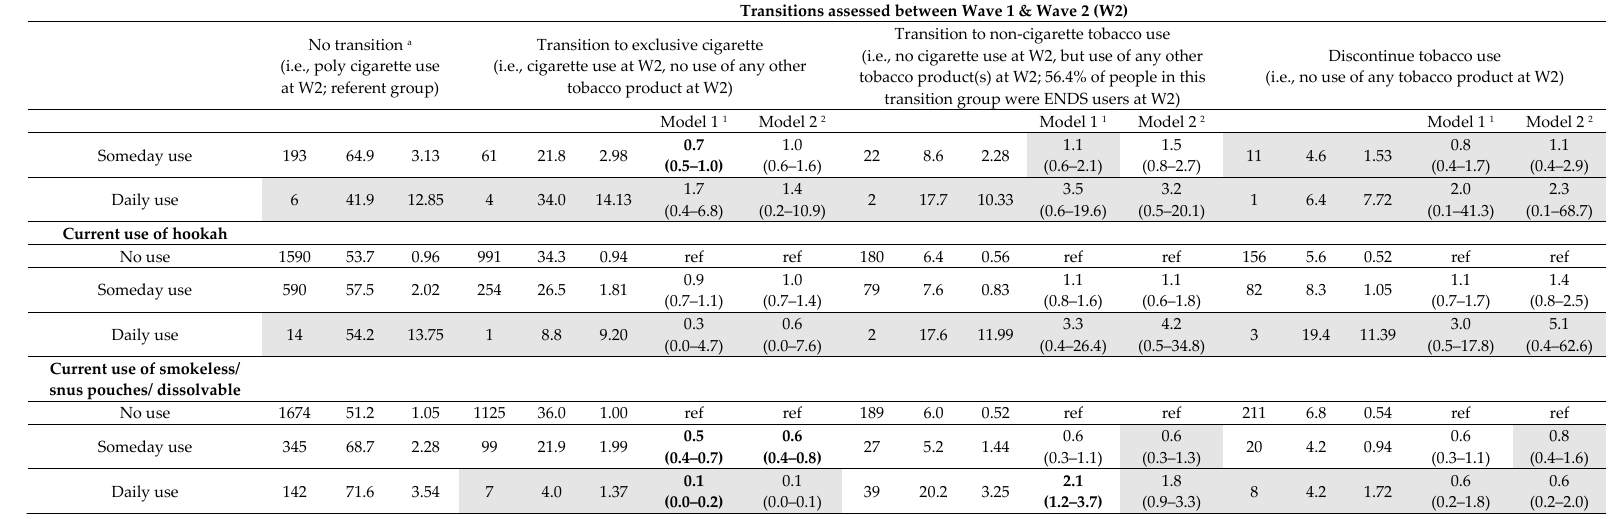
Table 1. Correlates of transitions in tobacco product use among ‘any tobacco’ users at Wave 1 (W1) of the Population Assessment of Tobacco and Health (PATH) Study ⱡ Table 4 notes. Sample includes adults aged 18+ years who were ‘poly cigarette’ smokers at W1 and also participated in W2 (N = 3946); analyses weighted using W2 longitudinal weights. Results from multinomial logistic regression analyses indicate the relative probability of being in each W2 transition group vs the W2 ‘no transition’ group as a function of correlates assessed at W1. Current use at each wave defined for cigarettes as having smoked at least 100 cigarettes in lifetime and now smoking everyday or somedays; for hookah as now using everyday, somedays, or monthly; for all other products as now using everyday or somedays. ‘Poly cigarette’ use defined as current use of cigarettes and current use of at least one